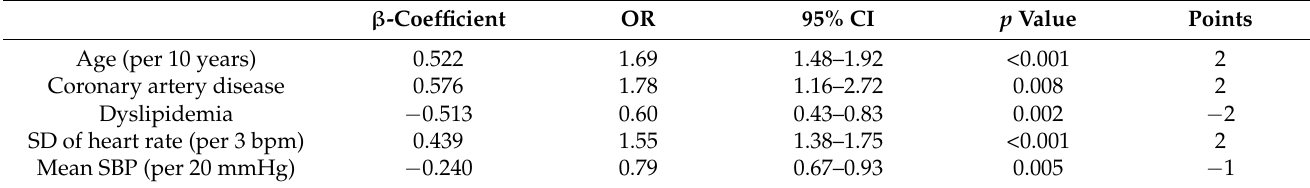
Table 2. Logistic regression model for diagnosis of paroxysmal atrial fibrillation.